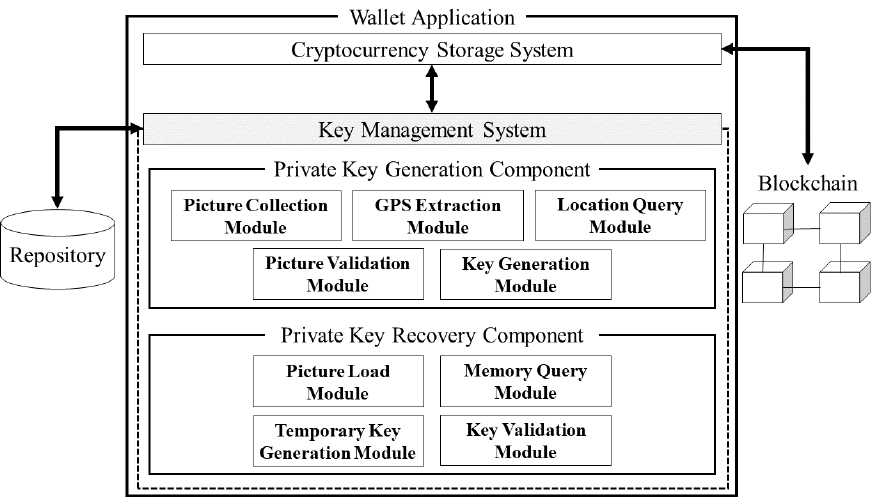
Figure 1. Module